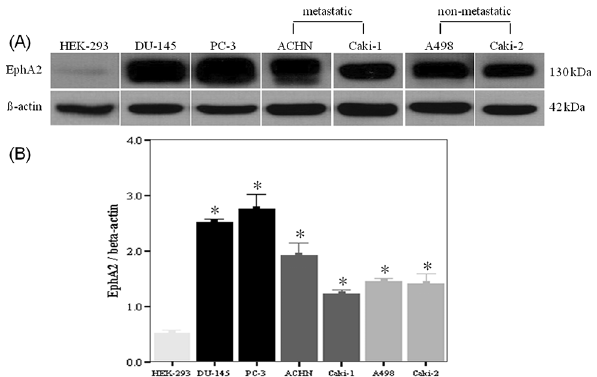
Fig 1. Western blot analysis demonstrating expression of EphA2 protein in human RCC cell lines. Representative immunoblots (A) and bar graphs (B) showing the comparison of EphA2 protein expression among the cell lines using densitometry. The results were normalized by β -actin expression. * p < 0.05 vs. HEK-293 cell. HEK-293 = human embryonic kidney-293, RCC = renal cell